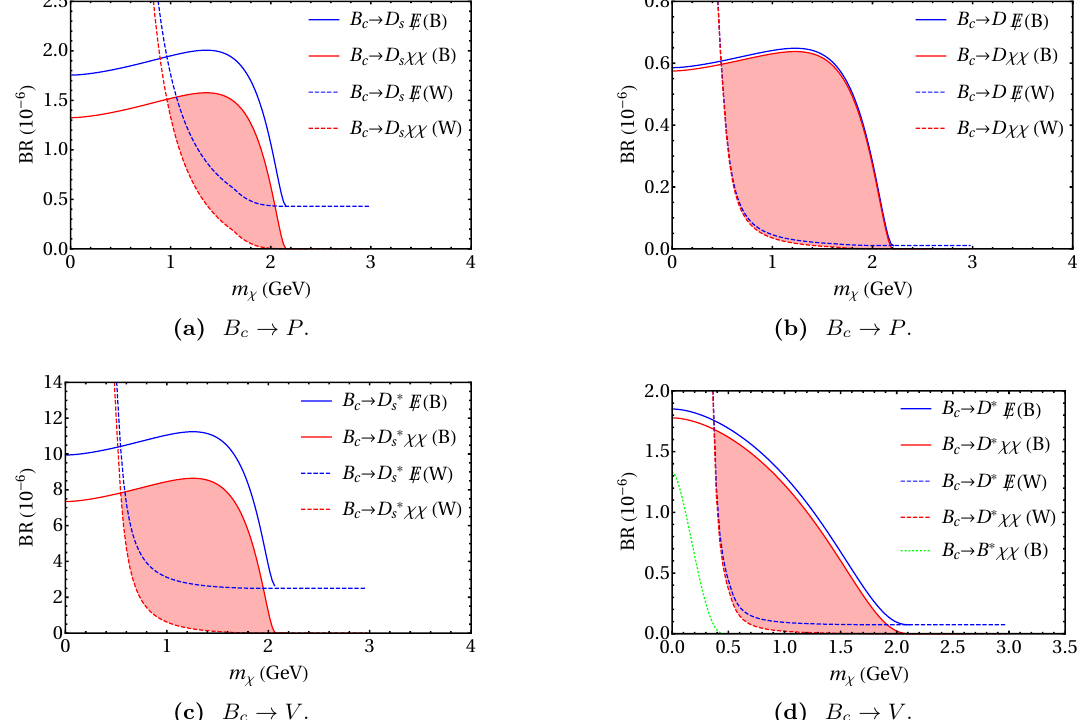
Figure 10. Branching ratios of B